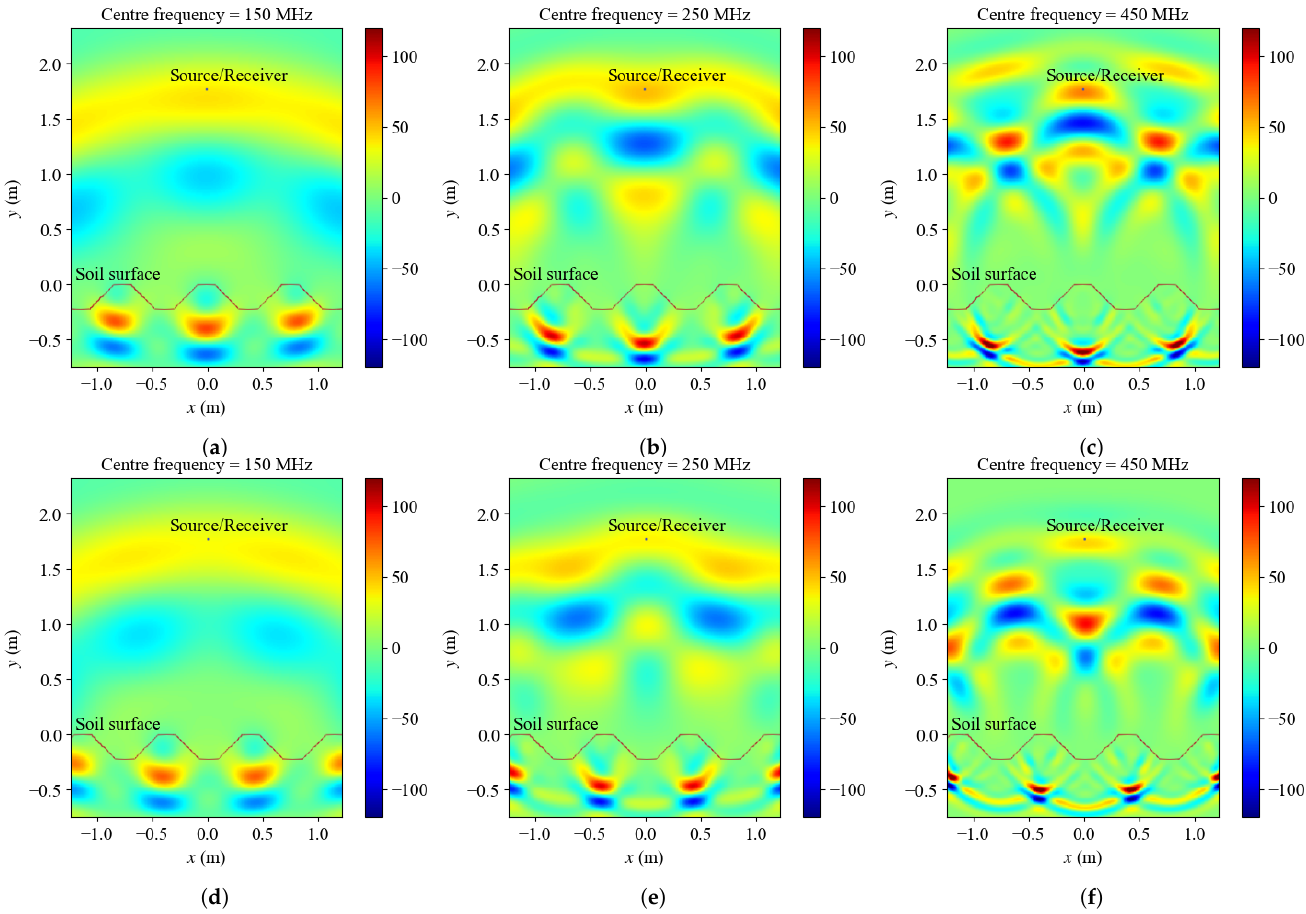
Figure 3. Intensity of the electric field for the three centre frequencies (150 MHz, 250 MHz and 450 MHz) and two configurations (source/receiver situated above the centre of the top ( a – c ) and the bottom ( d – f ). The propagation times as subcaptions were chosen from the peak of signals. Please note that the peaks do not correspond to the FDTD Green’s function in Figure 2 but to b ( t ) − h i ( t )